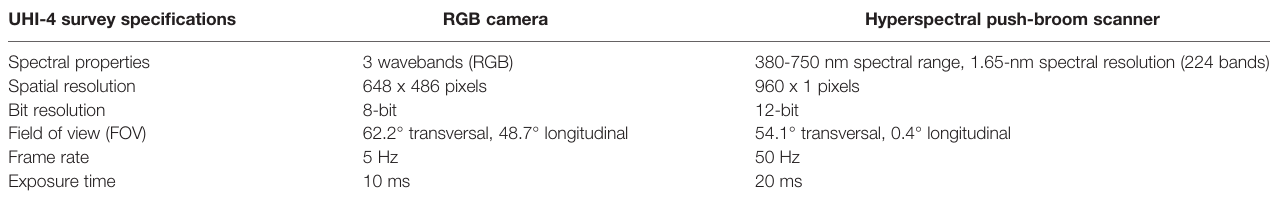
TABLE 1 | UHI-4 speci fi cations relevant for the 2017 cold-water coral (CWC) survey on the Tautra Ridge. UHI-4 survey speci fi